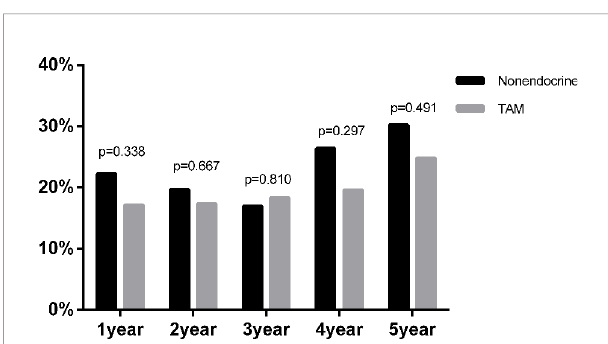
FIGURE 3 | The proportion of newly diagnosed dyslipidaemia after endocrine therapy in premenopausal BC.